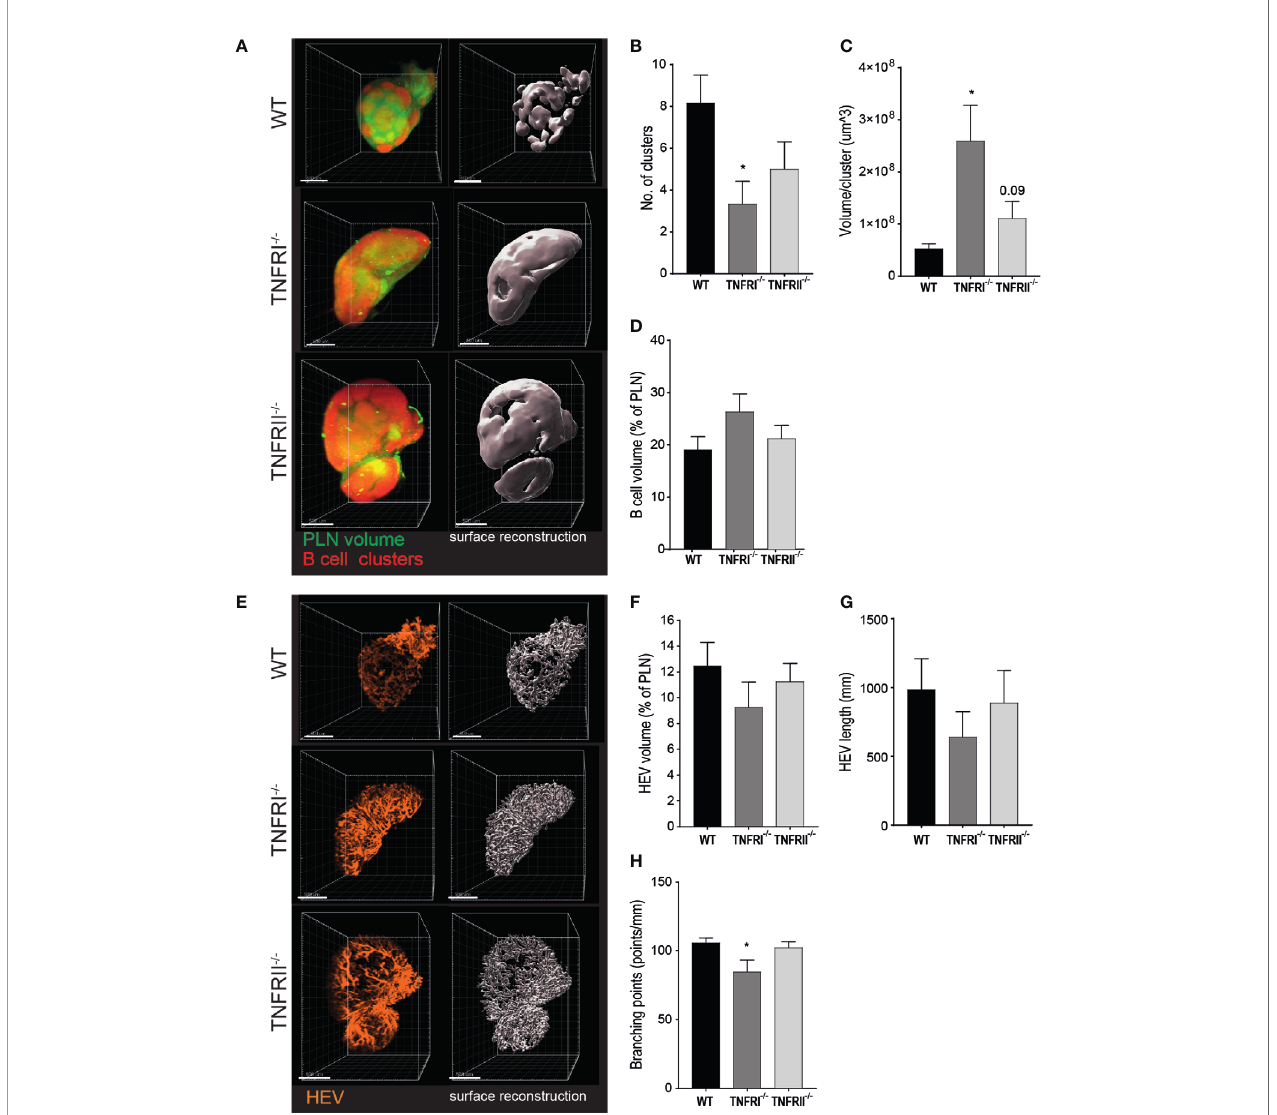
FIGURE 3 | TNFR signaling is involved in B cell cluster and HEV morphology. TNFRI- and TNFRII-signaling are involved in formation of individual B cell clusters (A – D) . (A) representative UM image (left; total PLN volume in green, B cell clusters in red) and 3D volumetric reconstruction (right; B cell clusters shown in white) of PLN for each phenotype. (B) number of individual B cell clusters per PLN. (C) average volume per B cell cluster. (D) total B cell volume. TNFRI-, but not TNFRII-de fi ciency affects HEV morphological features (E – H) . (E) representative UM image (left) and 3D volumetric reconstruction (right) of high endothelial vasculature for each phenotype. (F) total HEV volume. (G) total HEV length. (H) number of branching points. Scale bars: 500 m m. PLN; peripheral lymph node. n = 5 to 6. *p <